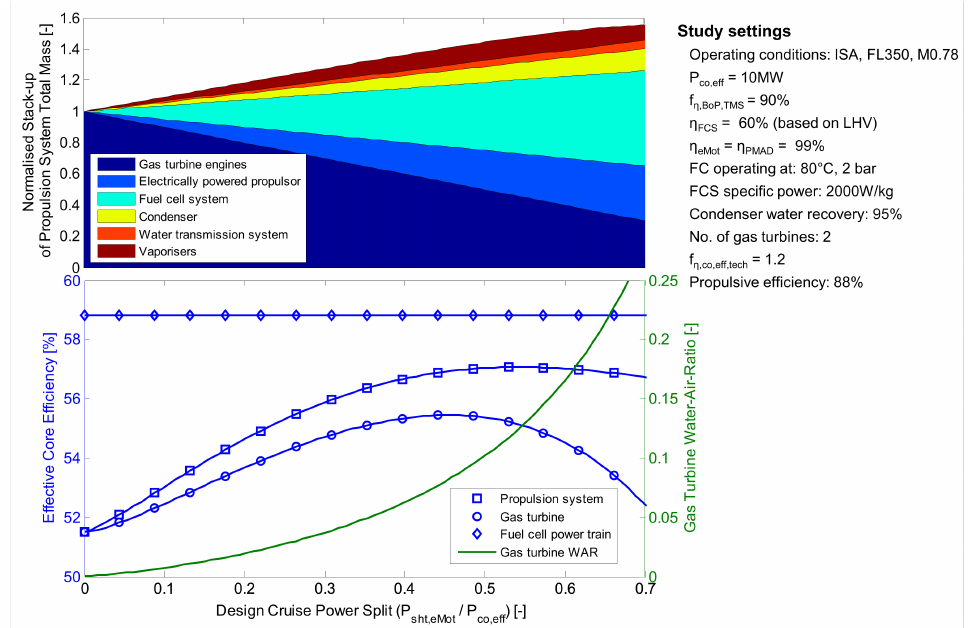
Figure 9. Effective core efficiency and propulsion system mass breakdown results of initial power system design